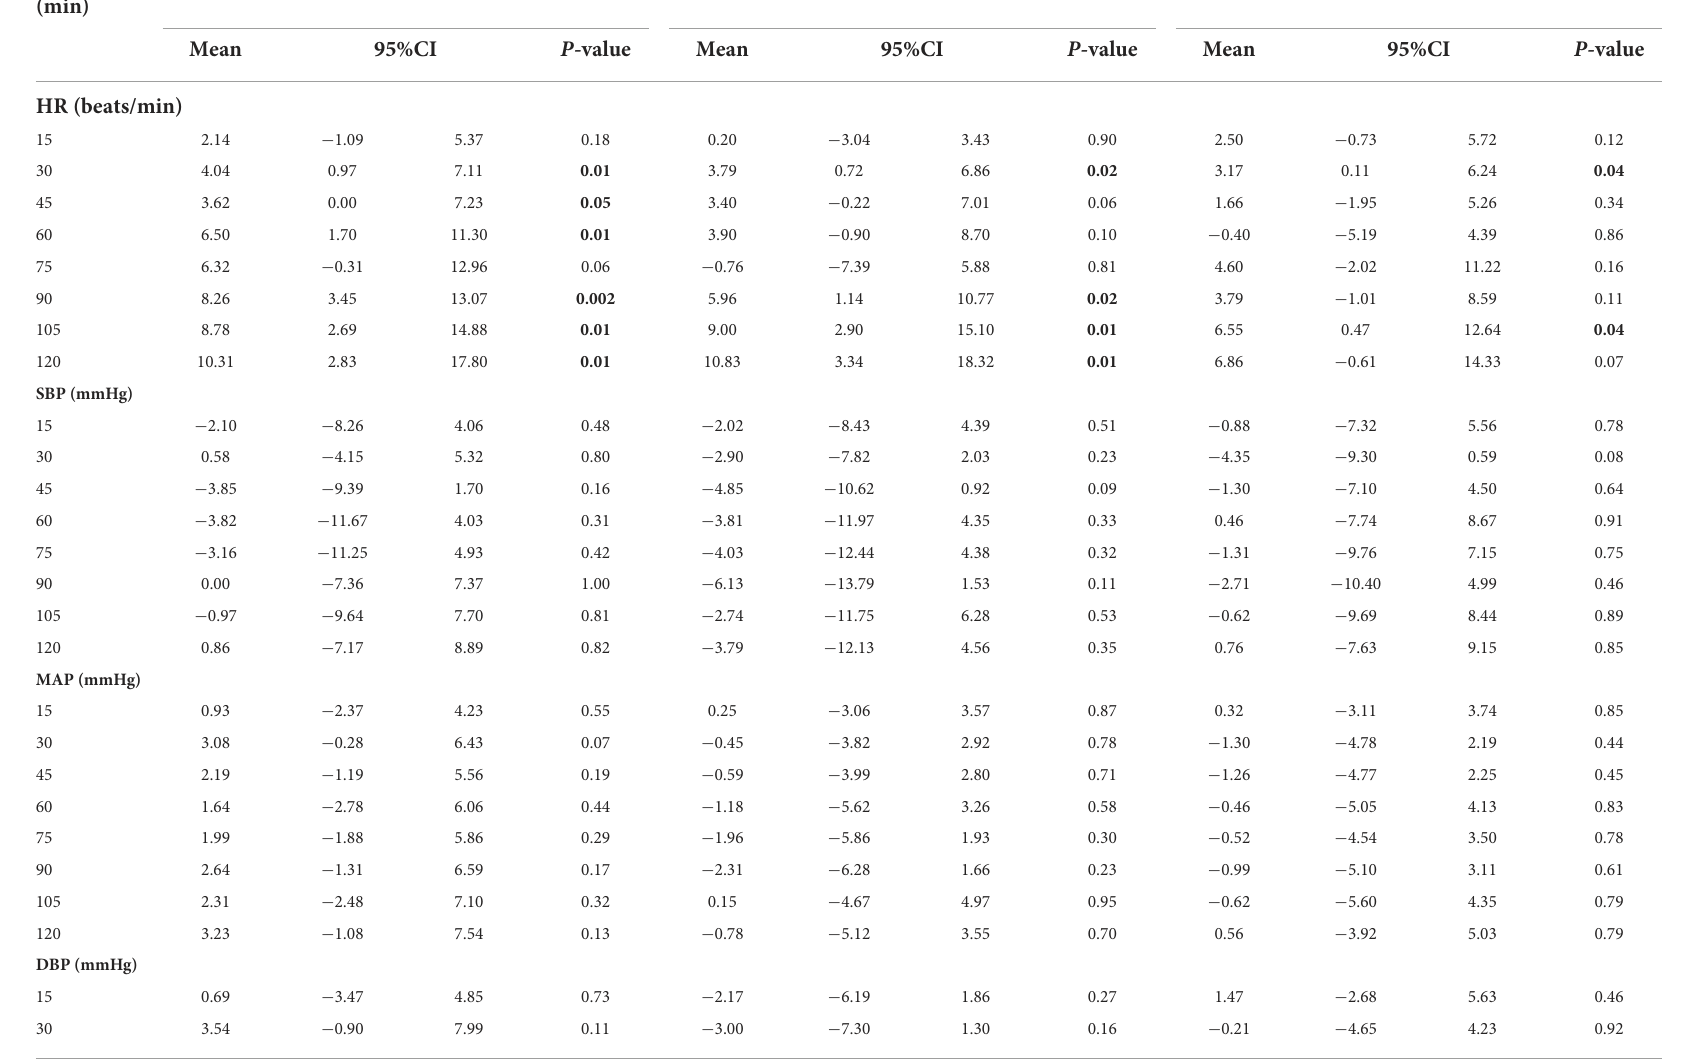
TABLE 1 Heart rate and blood pressure measurements after pimobendan injection in comparison with measurements at the baseline (Time 0). Time Saline (min)